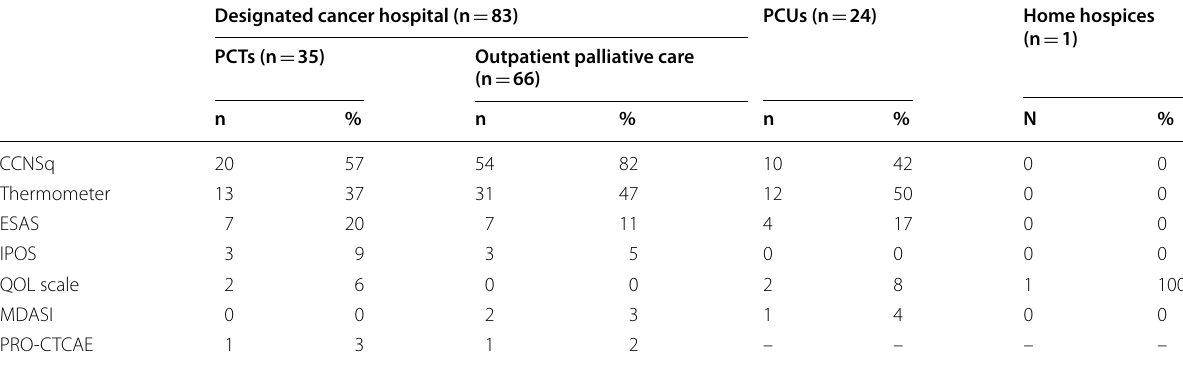
CCNSq Comprehensive Care Needs Survey questionnaire; ESAS Edmonton Symptom Assessment System; IPOS Integrated Palliative care Outcome Scale; MDASI MD Anderson Symptom Inventory; PCT palliative care team; PCU palliative care unit; PROMs patient-reported outcome measures; PRO-CTCAE patient-reported outcomes version of the common terminology criteria for adverse events; QOL quality of life